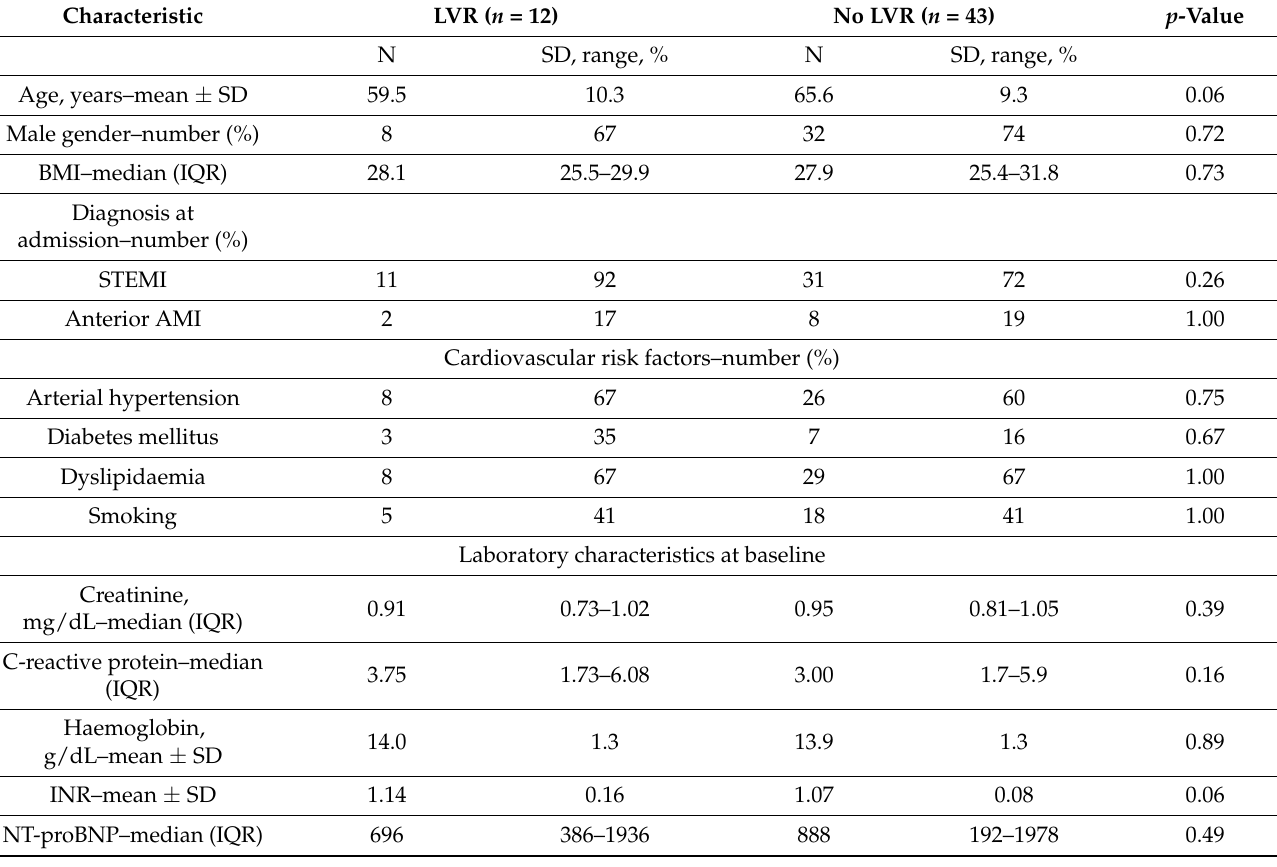
Figure 1. Study design ( A ) and inclusion and exclusion chart ( B ) Abbreviations: AMI – acute myocardial infarction; ASA – acetylsalicylic acid; GP – glycoprotein; PCI – percutaneous coronary intervention. Table 1. Main characteristics of patients with and without left ventricular remodelling (LVR) at 6 months after acute myocardial infarction.